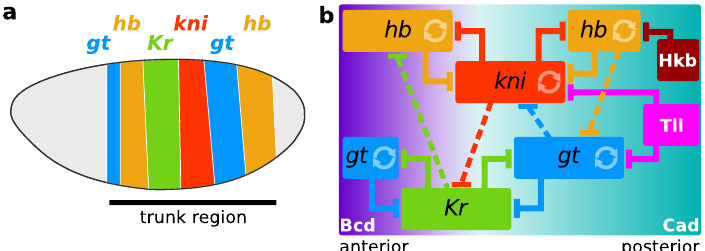
Figure 1. Body plan patterning in D. melanogaster . In both panels, the trunk gap genes are hunchback ( hb ), Krüppel ( Kr ), giant ( gt ), and knirps ( kni )). External inputs to these four genes are the maternal factors Bicoid (Bcd), Caudal (Cad), and the terminal gap proteins Tailless (Tll), and Huckebein (Hkb). ( a ) Schematic depiction of a Drosophila embryo with the anterior (head) oriented to the left and its dorsal side to the top. Gap gene expression domains are shown as vertical bands along the trunk region. Expression in the head and terminal area is omitted; ( b ) The gap gene network mapped onto the expression domains of the trunk region. Background gradients of Bcd (purple) and Cad (cyan) activate the gap genes. Each rectangle is an expression domain. Circular arrows indicate self-activation, interactions with T-bars represent inhibition. Dashed interactions signal a net